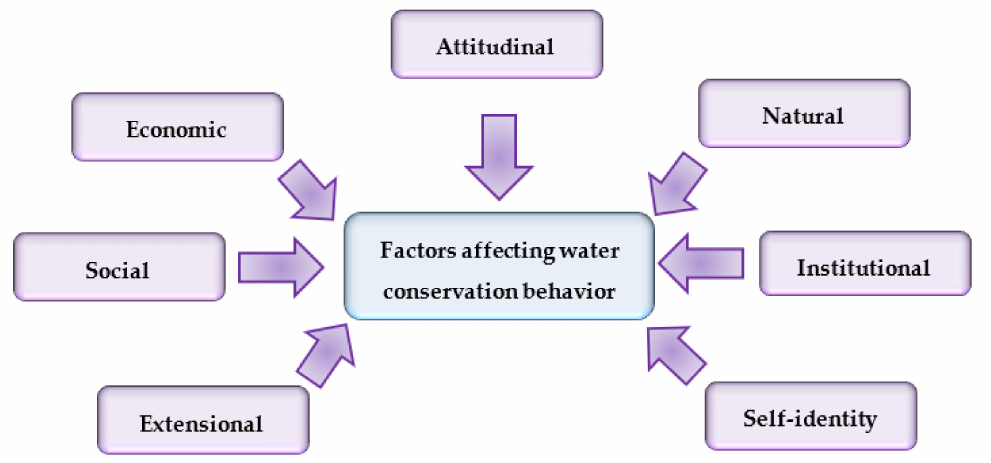
Figure 2. Mind map of factors affecting the water conservation behavior of wheat farmers.